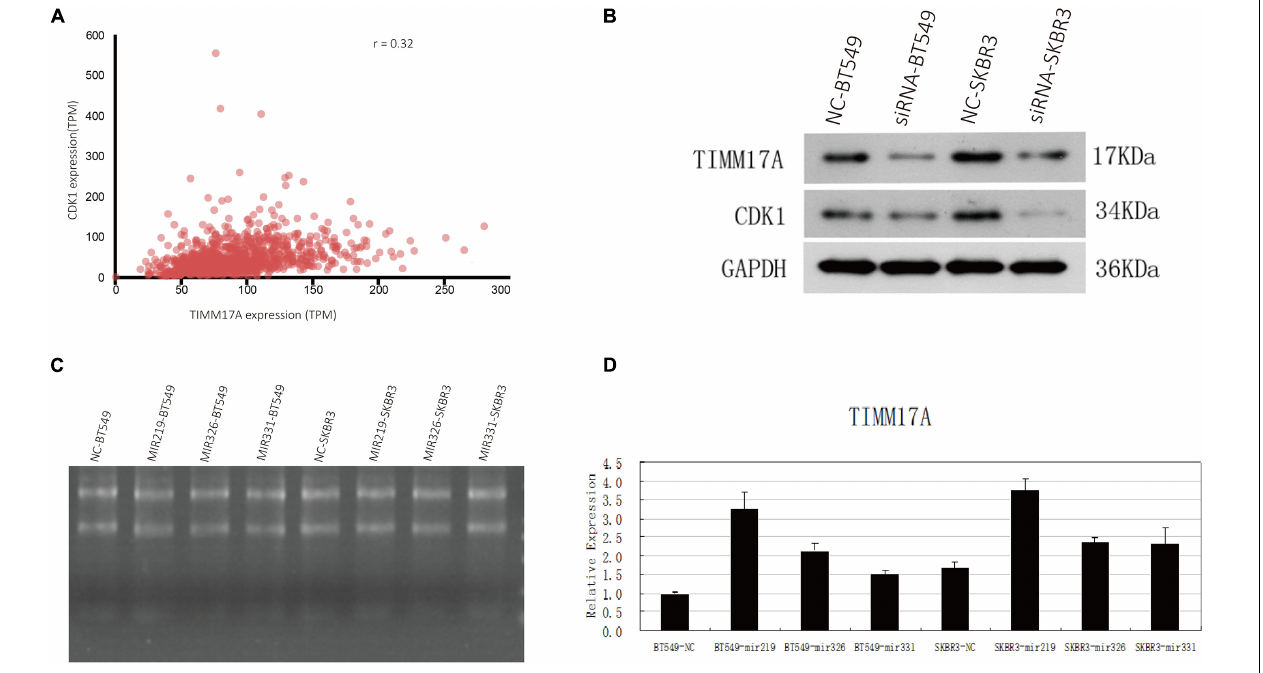
To validate the association between CDK1 and TIMM17A , we analyzed the correlation between TIMM17A expression and CDK1 expression both in silico and in BRCA cell